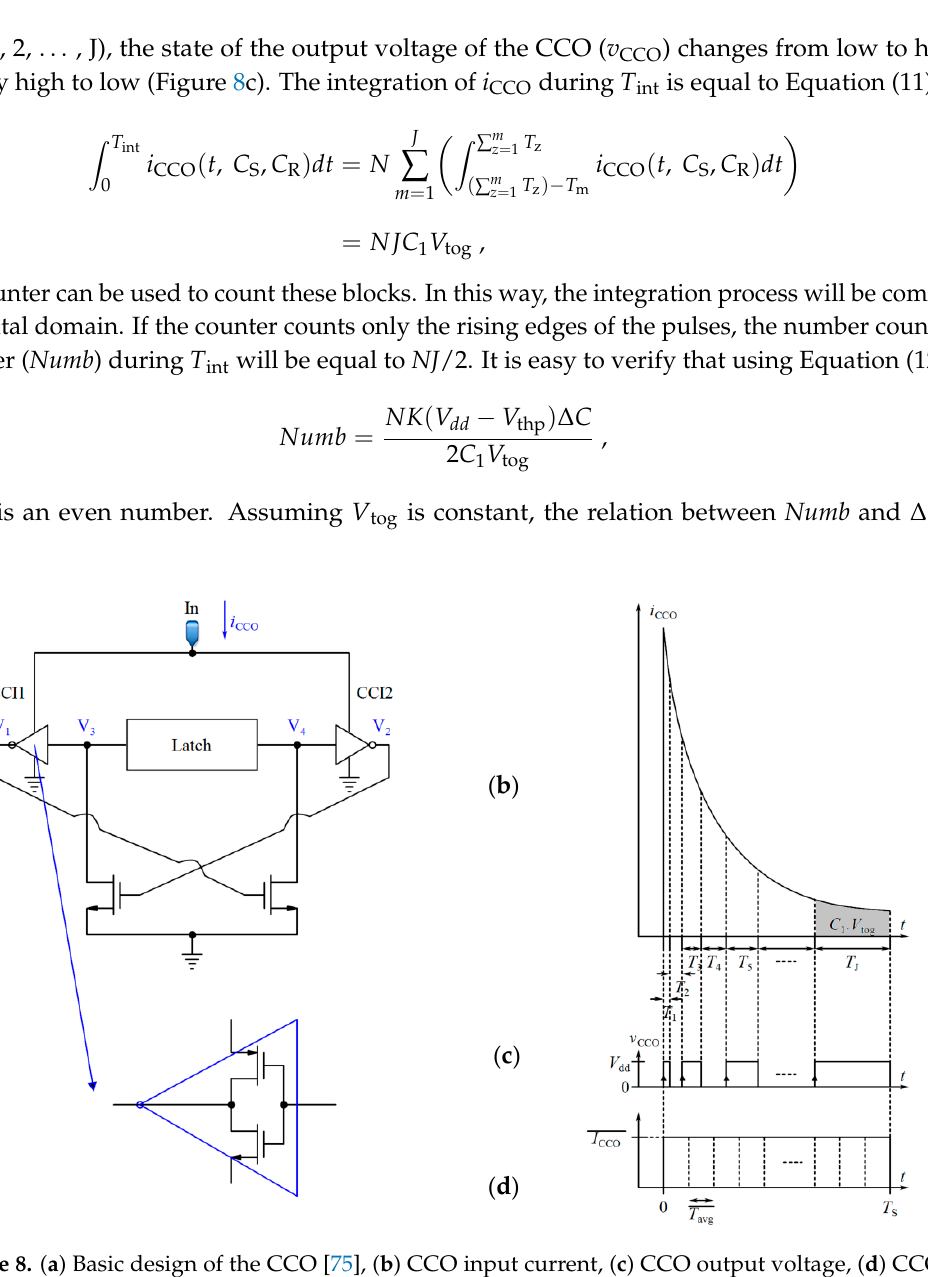
Figure 8. ( a ) Basic design of the CCO [75], ( b ) CCO input current, ( c ) CCO output voltage, ( d ) CCO averaged input current based on the mean value theorem.